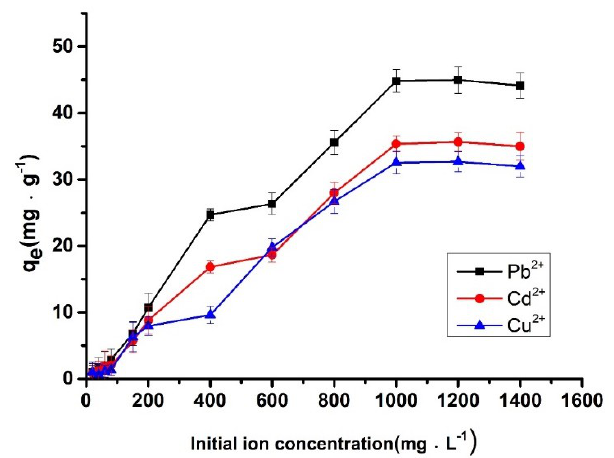
Figure 5. Adsorption isotherms for Pb 2 + , Cd 2 + , and Cu 2 + on the adsorbents at heavy metal ions concentrations from 20 to 1400 mg · L − 1 , an adsorbent dose of 12.5 g · L − 1 , an agitation speed of 150 rpm, a temperature of 30 °C, and a contact time of 24 h.